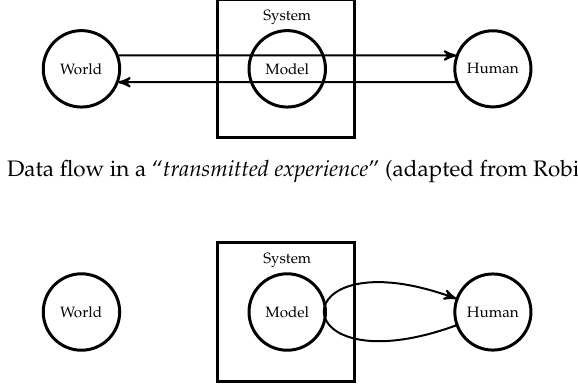
Figure 8. Data flow in a “ simulated experience” (adapted from Robinett [4]).